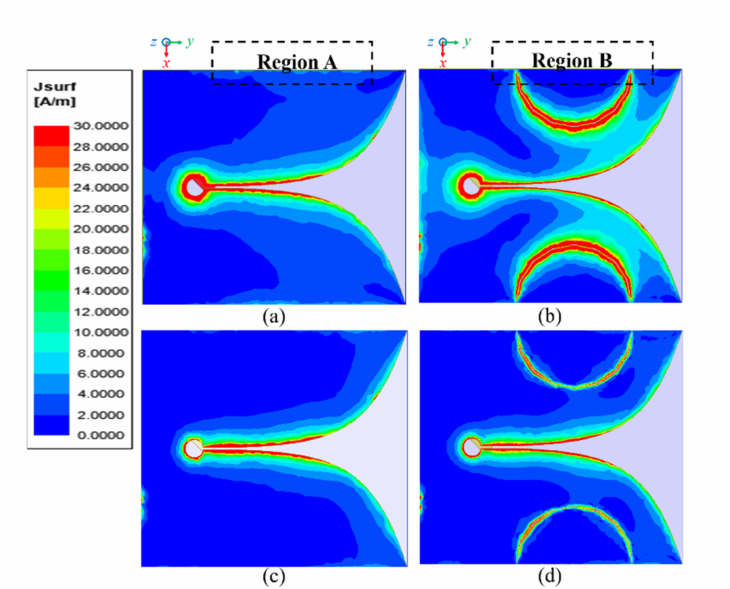
Figure 2. Electric surface current distributions of the conventional Vivaldi antenna and SPEVA, respectively, ( a ) and ( b ) at 3 GHz, and ( c ) and ( d ) at 7